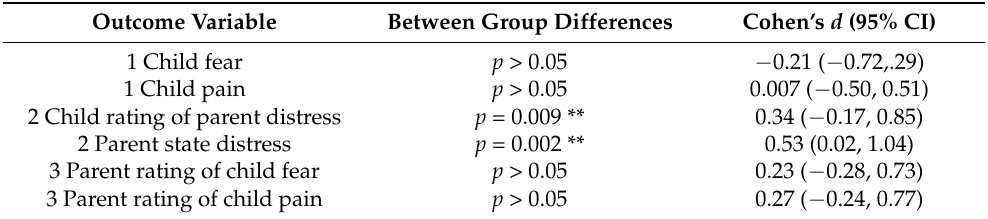
Table 3. Means, standard deviations, and t -tests comparing differences between groups on the RCT outcome